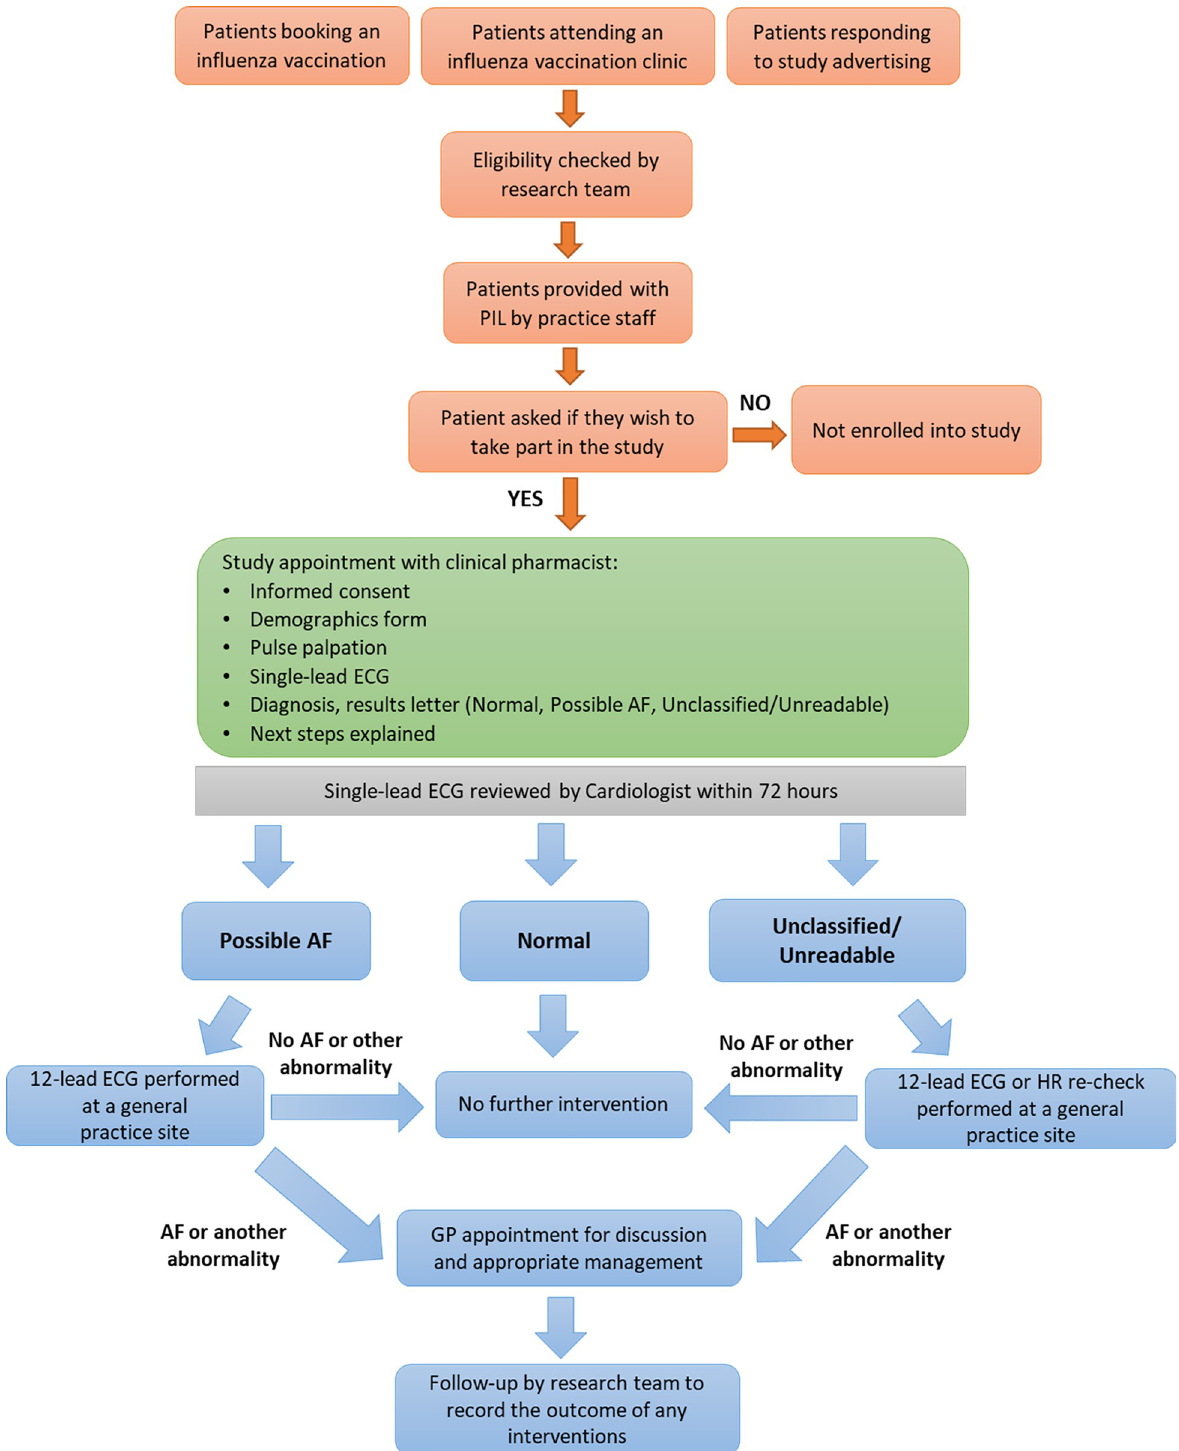
Fig 1. Pharmacists Detecting Atrial Fibrillation study intervention flowchart. AF, atrial fibrillation; GP, general practitioner; HR, heart rate; PIL, participant information leaflet.